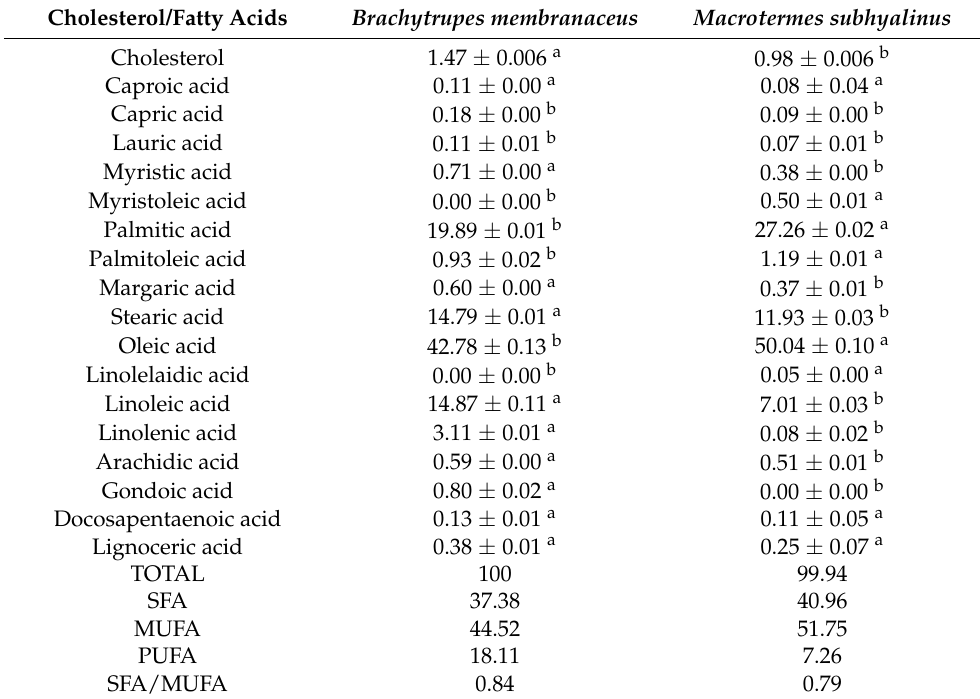
Table 3. Cholesterol content (g/100 g fat) and fatty acid composition (%) of Brachytrupes membranaceus and Macrotermes subhyalinus .